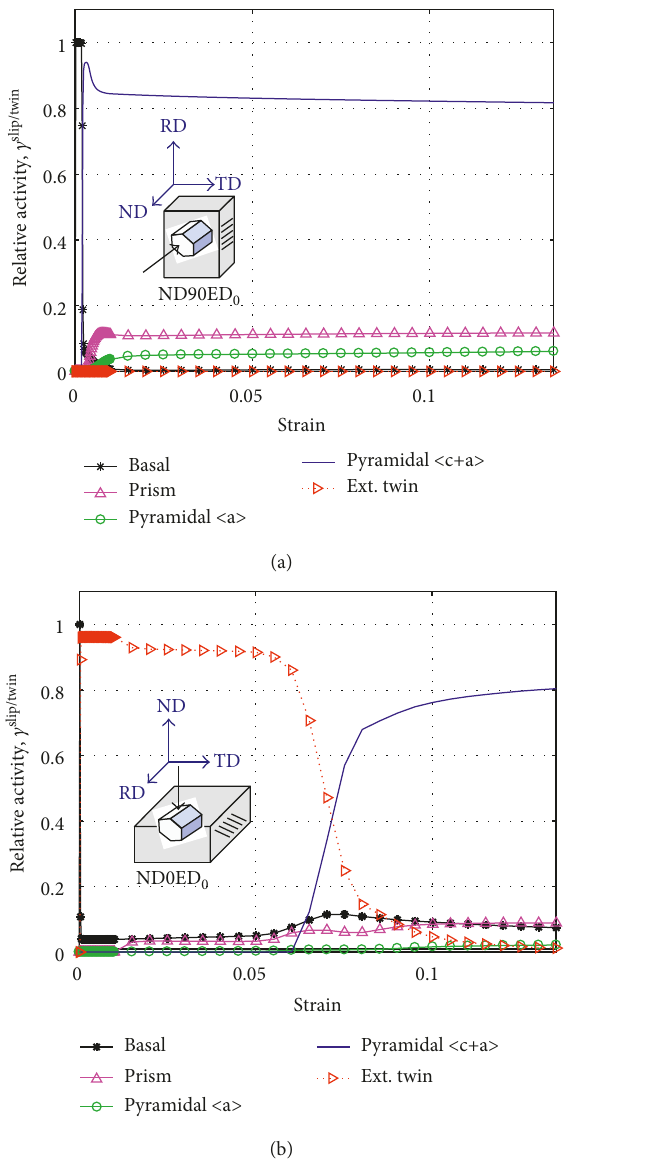
Figure 10: Relative slip and twin activities predicted by crystal plasticity simulation during simple compression of pure Mg for the two sample orientations tested in this study: (a) CA0ND 0 (CA ‖ c -axis) and (b) CA0ED 0 (CA ⊥ c